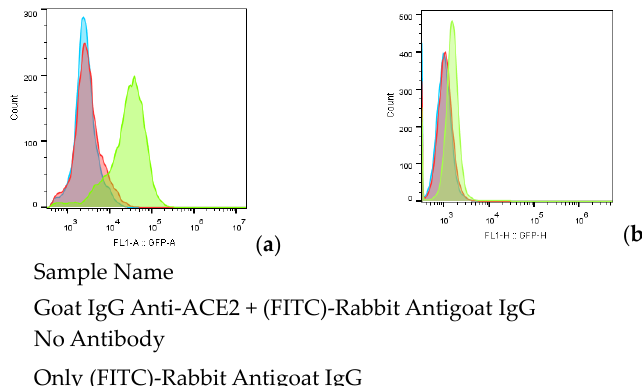
Figure 1. Expression levels of ACE2 receptor in HEK 293-ACE2 cells ( a ) and HEK 293T cells ( b ).